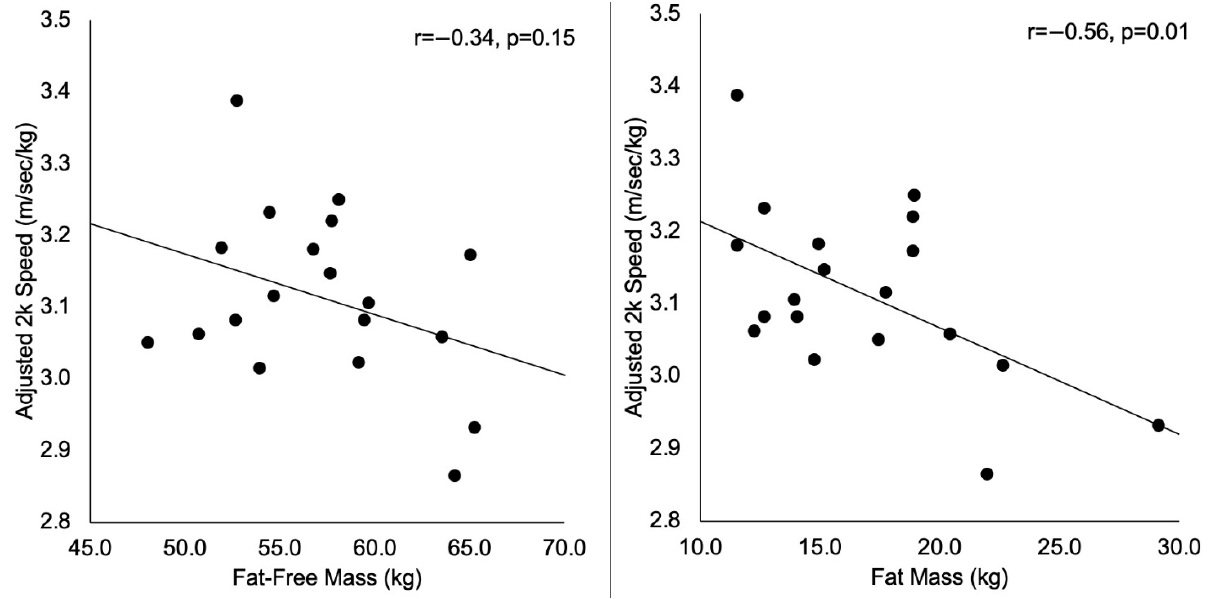
Figure 3. Scatterplots representing the relationships between adjusted 2 km (2k) speed and the body composition metrics.